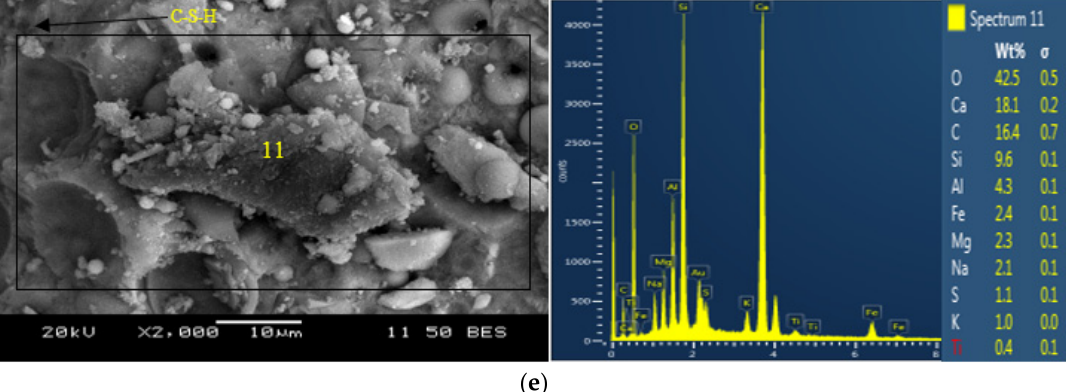
Figure 15. ( a ) SEM micrographs and EDS analysis of the binary binder CS1. ( b ) SEM micrographs and EDS analysis of the binary binder CS2. ( c ) SEM micrographs and EDS analysis of the ternary binder CFS1. ( d ) SEM micrographs and EDS analysis of the ternary binder CFS2. ( e ) SEM micrographs and EDS analysis of the control cement binder FP C .